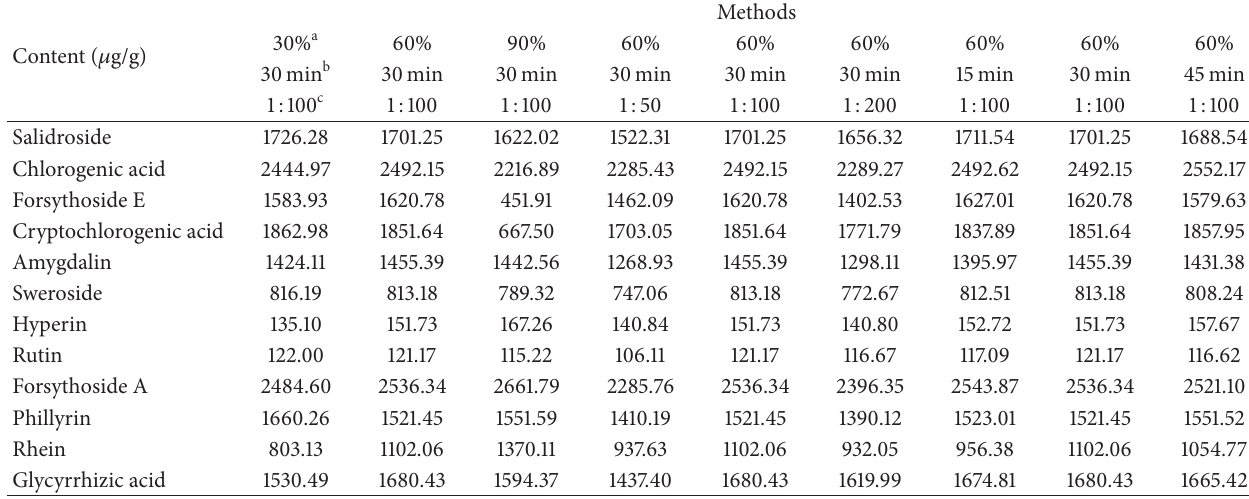
Table 1: Quantitative results of 12 compounds in LQC extracted by different methods.